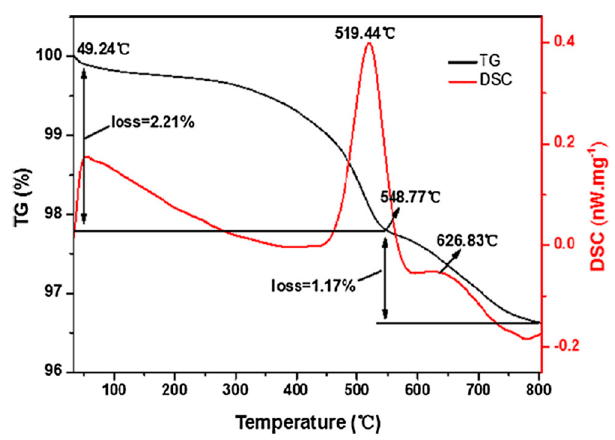
Figure 7. Thermogravimetry-di ff erential scanning calorimetry (TG-DSC) curves of spent laptop Li-ion batteries in air (reproduced with permission from Springer Nature Ref.